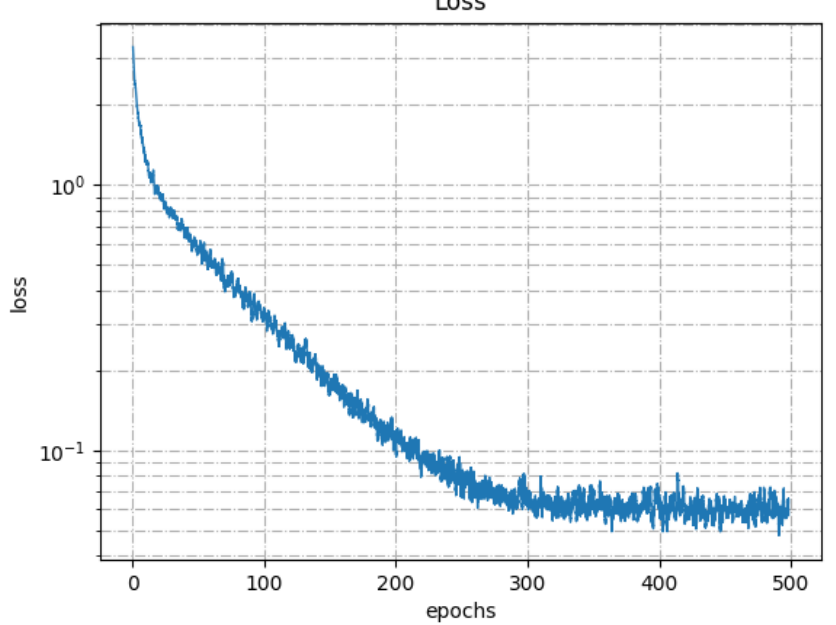
Figure 9. The loss curve for ModelNet40 classification.